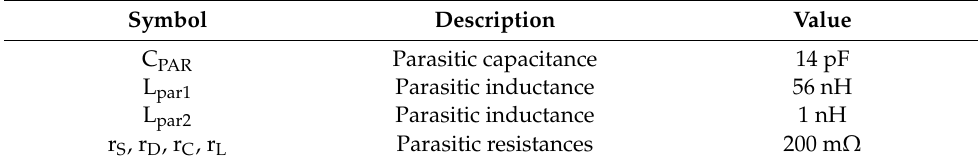
Table 1. Values of the parasitic components of the Buck Converter model LM2596.